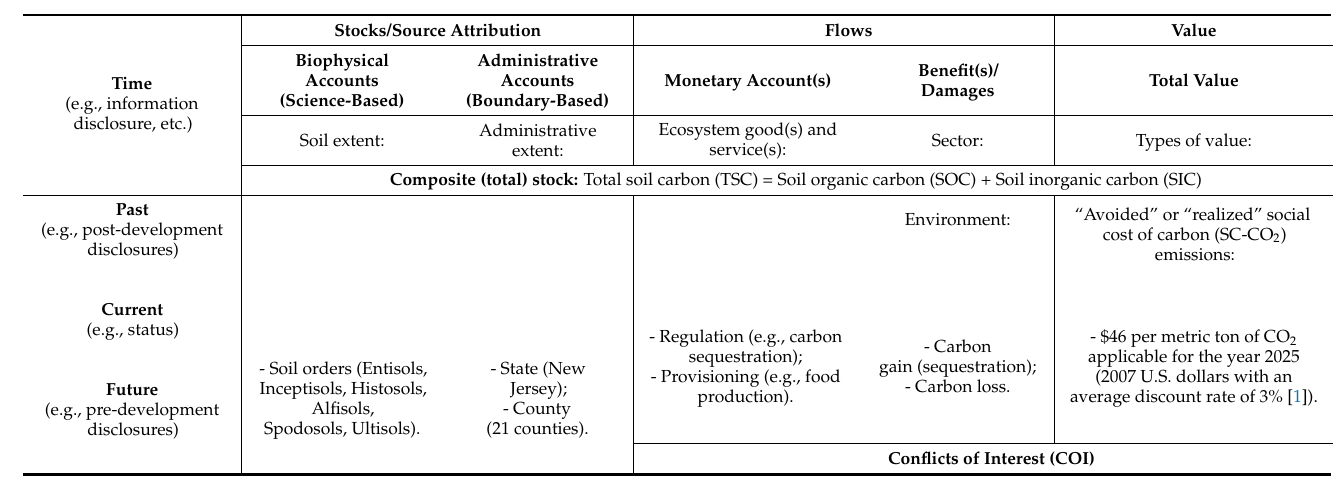
Table 2. An overview of the accounting framework (including conflicts of interest, COI) used by this research (adapted from Groshans et al. (2019)